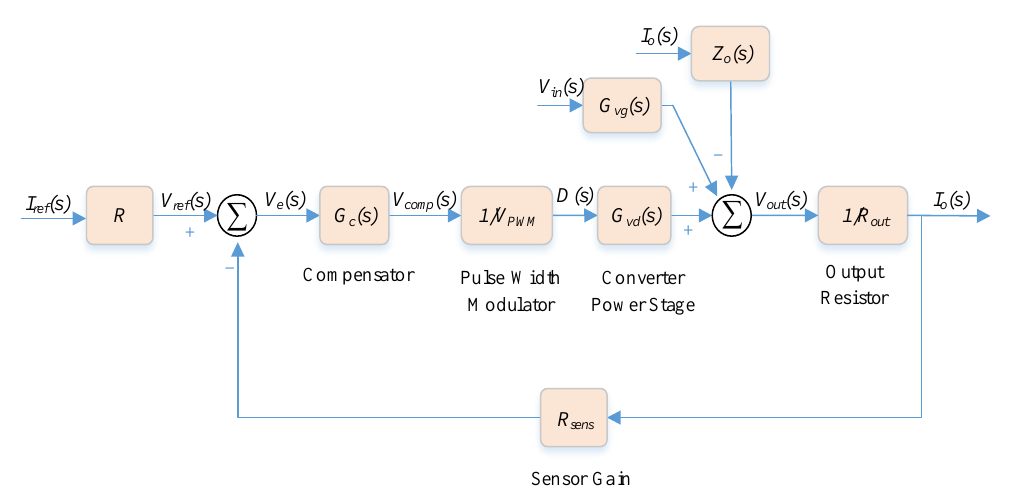
9 of 18 Figure 6. Curve fitted for different values for conversion ratio ( M ) and Peak to Average Ratio (PTAR). 4. Proposed Control Circuit and Simple Implementation Taking the benefits described in the previous section, the control loop that reshapes the required LED current will be derived in this section using a straightforward control block. The harmonic combinations obtained from the MATLAB script for the output LED current. The duty cycle can be expressed as a Fourier series expansion using the curve fitting as: 𝑑(𝑡) = 𝐷 0 − ∑ 𝐷 (2𝑛)∞ 𝑛=1 𝑐𝑜𝑠 2𝑛𝜔 𝐿 𝑡.